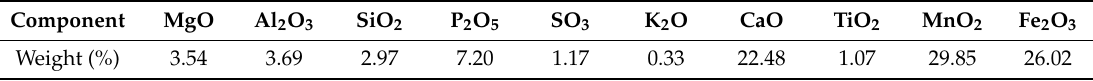
Table 1. Chemical analysis (in the form of oxides) of manganese